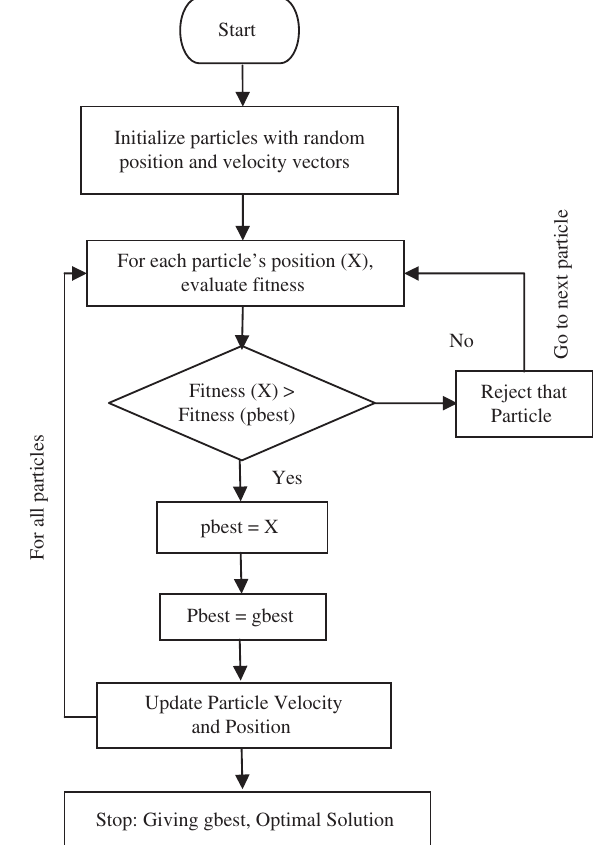
Figure 2. Flow chart of particle swarm optimization.